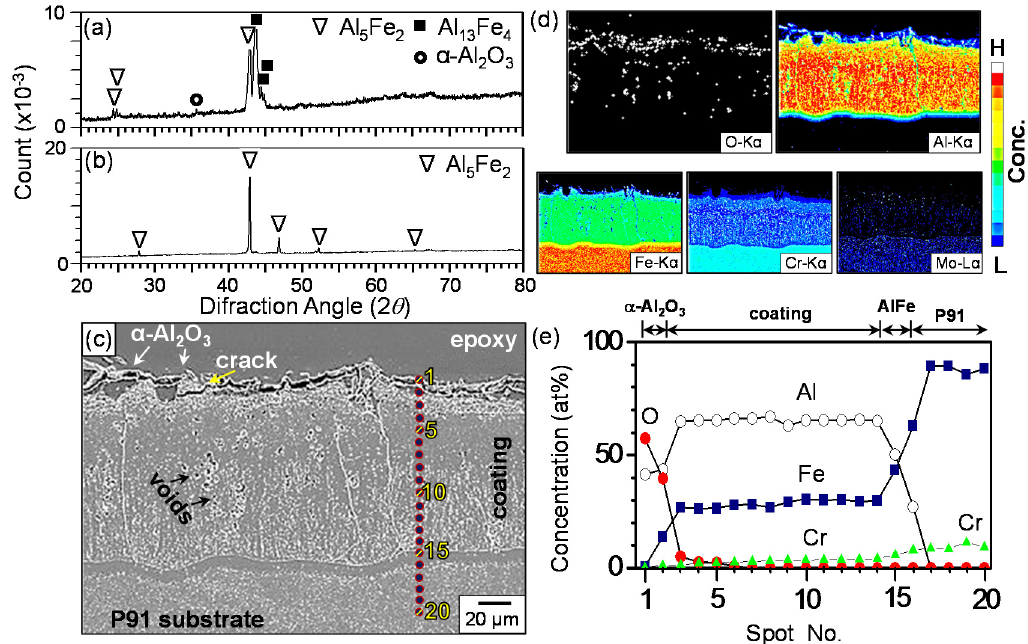
Figure 3. Al hot ‐ dipped P91 steel after oxidation at 700 °C for 100 h. ( a ) XRD pattern before grinding; ( b ) XRD pattern after grinding off the surface; ( c ) etched electron probe microanalyzer (EPMA) cross ‐ sectional image; ( d ) EPMA maps of (c); ( e ) EDS concentration profiles along spots 1–20 marked in (c).